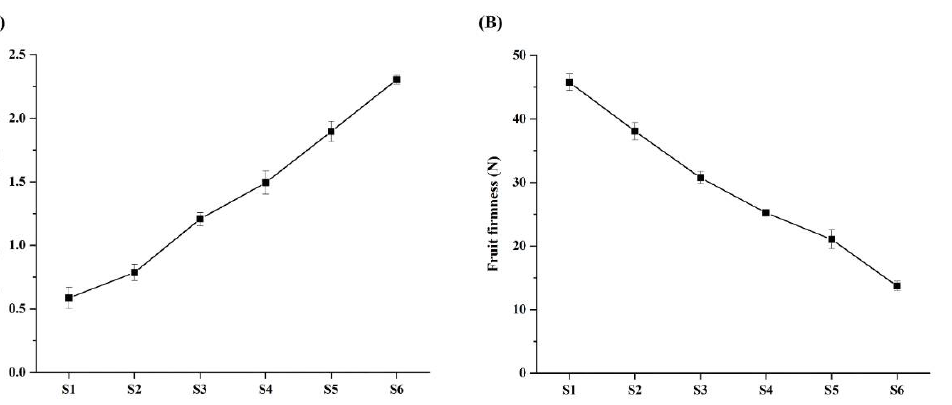
Figure 7. Changes in ethylene production (A) and fruit firmness (B) . The horizontal axis represents the stages of fruit development. The error bar on data represents the standard error ( ± ) of three individual repeats.